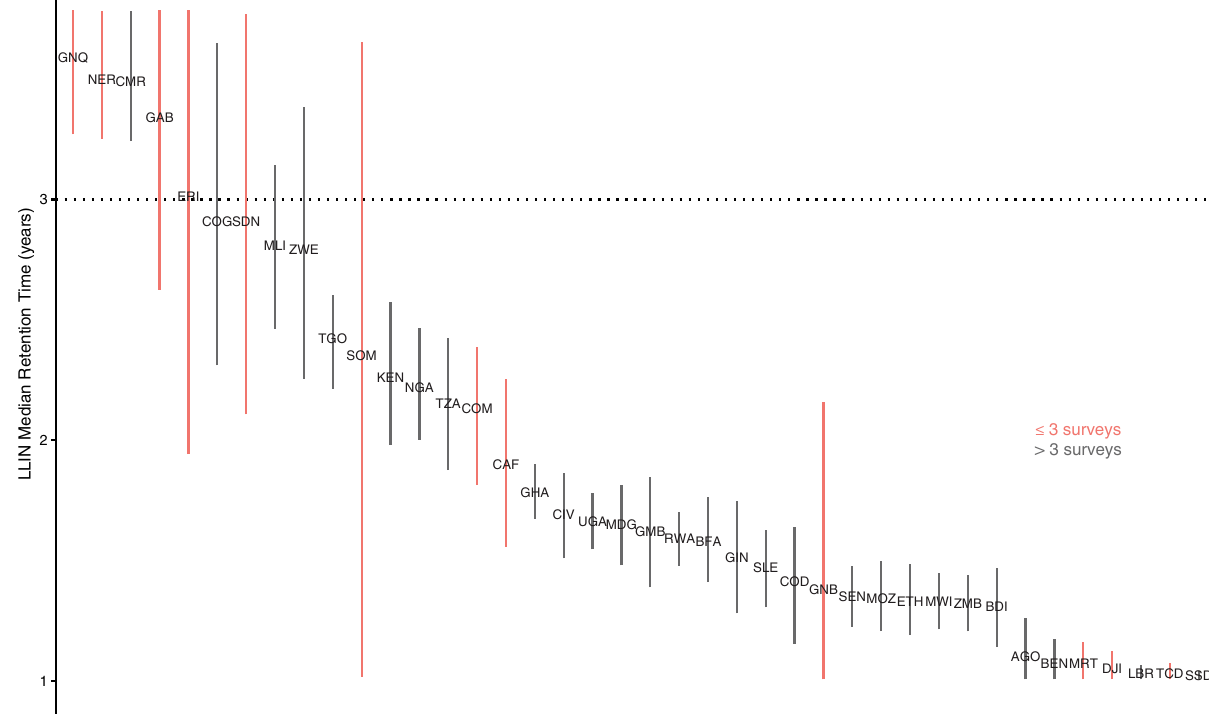
Fig. 5 Long-lasting insecticide-treated net (LLIN) median retention times. Stock-and- fl ow estimates of median LLIN retention time by country, ordered from highest to lowest . Countries are labeled by IS03 code. Country labels are positioned at mean parameter values, while vertical bars indicate 95% con fi dence interval width. Countries with fewer surveys have less stable model fi ts (see Supplementary Section 1.6); those having fewer than three surveys are indicated in red. The lower bound of LLIN retention time was capped at 1 year during model fi tting. Supplementary Table 1.7 shows all data for this fi gure in numerical format and maps ISO3 codes to country